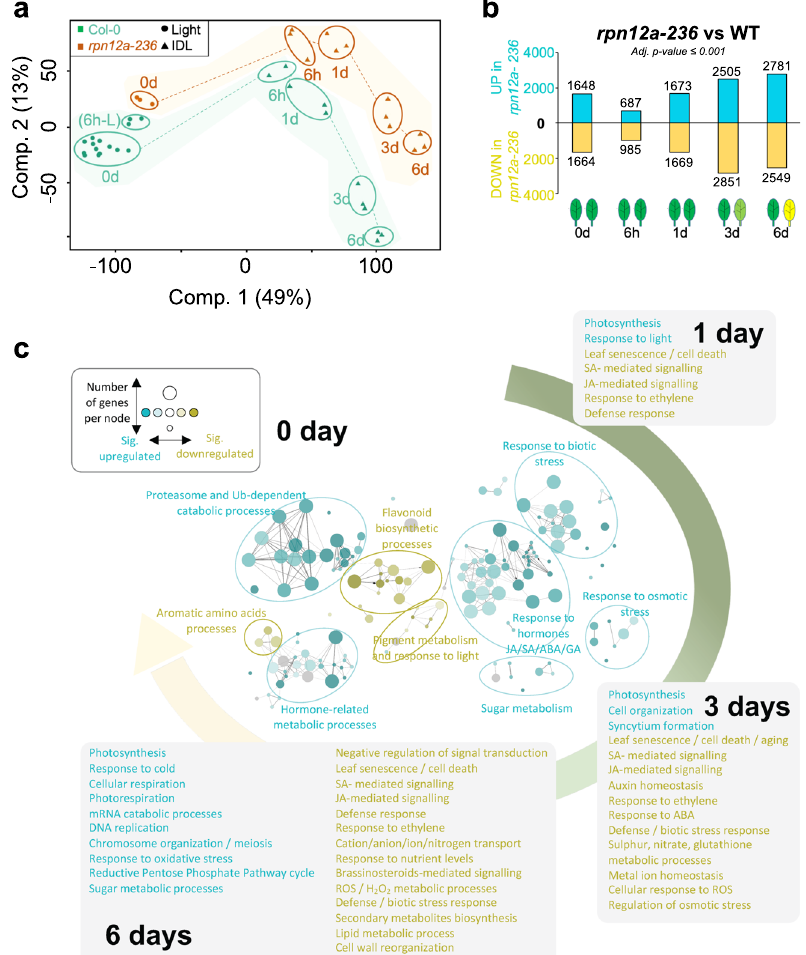
Fig. 4 Transcriptomic analysis of WT Col-0 and rpn12a-236 in response to IDL treatment. a Resemblances and variations within the RNA-seq samples were observed by PCA; fi rst component (49%) and second component (13%). b Differential expression analysis ( P ≤ 0.001) between WT and mutant across the IDL time-course. Number of genes up- and downregulated between the two genotypes at a given time point are shown above and under the histograms, respectively. c Biological network of enriched GO terms (Biological Process) from signi fi cantly ( p < 0.001) differentially expressed genes in rpn12a-236 versus WT. Enriched GO terms upregulated in rpn12a-236 (palette of blues) or downregulated (palette of yellows) were clustered according to their functional categories. The size of a node is proportional to the number of genes contributing to this node, while the intensity of the color is proportional to the signi fi cance of it (the minimum for signi fi cance being p < 0.05); gray nodes = overrepresented in the gene subset but not enriched signi fi cantly; the threshold of signi fi cance was set at 60%. For day 1, 3, and 6, the subset of genes differentially regulated at day 0 was subtracted to highlight the functional categories associated with cell death and minimize the constitutive contribution of a non-functional proteasome (see